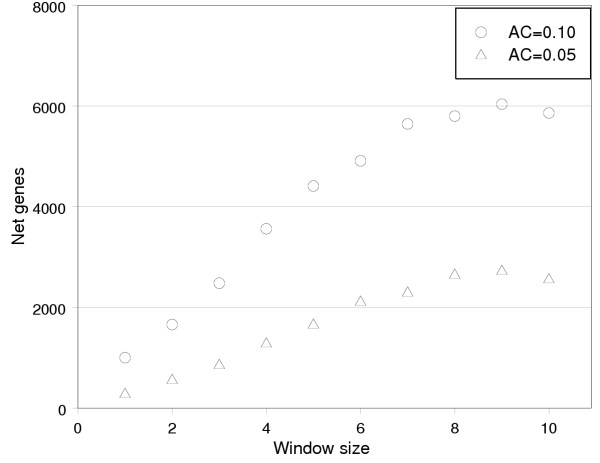
Net genes for simulated data. Number of genes that contribute to a high moving average of Pearson R in simulated data, as a function of the size of the windows used for computing the moving average. The shapes of the curves are similar to the findings by Spellman and Rubin, although the convergence is somewhat faster. The simulated data are first-order Gaussian autocorrelation processes.